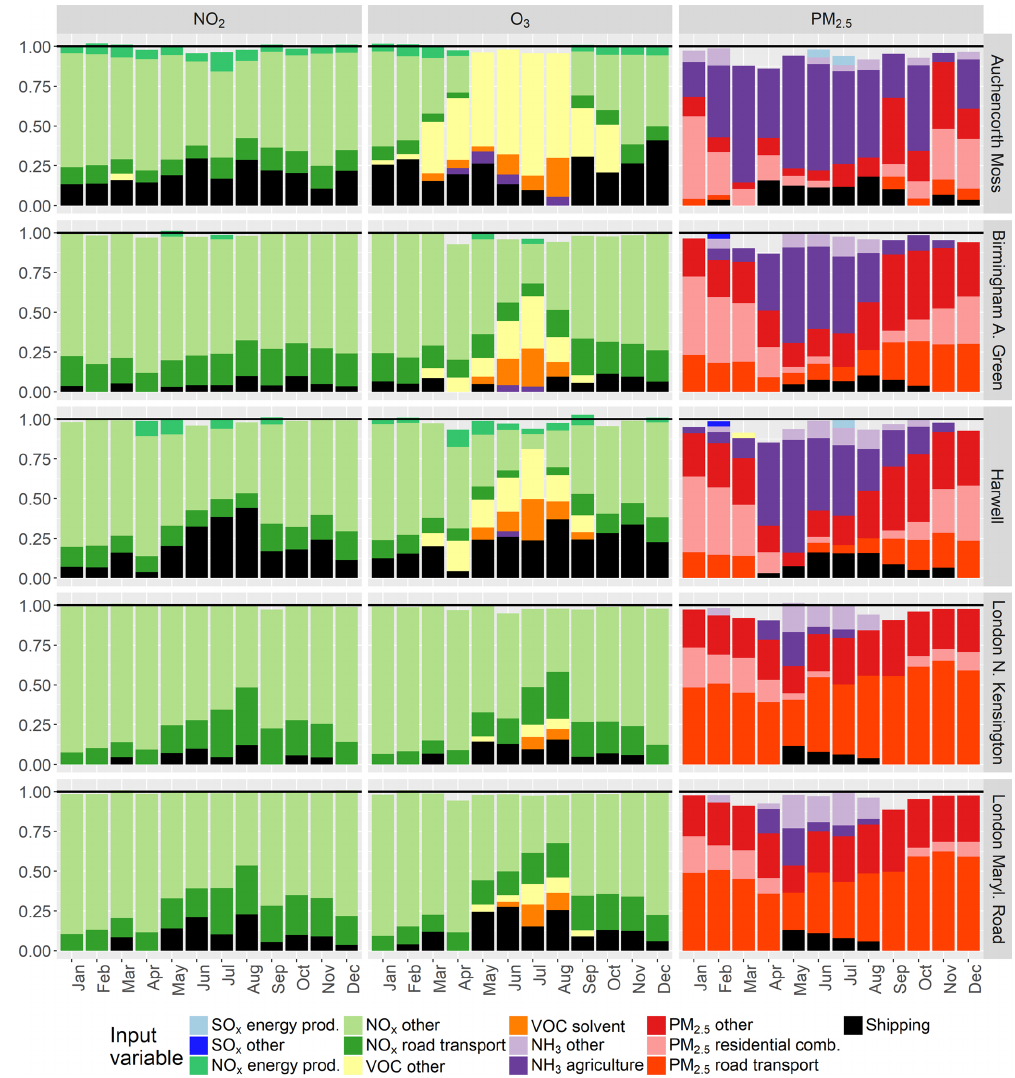
Figure 8. Monthly variation in the first-order sensitivity indices for five grid cells across the UK representing a spread of geographical locations and environment types. Based on the monitoring station classification, grid squares are assigned the following environment types: Auchencorth Moss and Harwell – rural background; Birmingham Acocks Green and London N. Kensington – urban background; and London Marylebone Road – urban